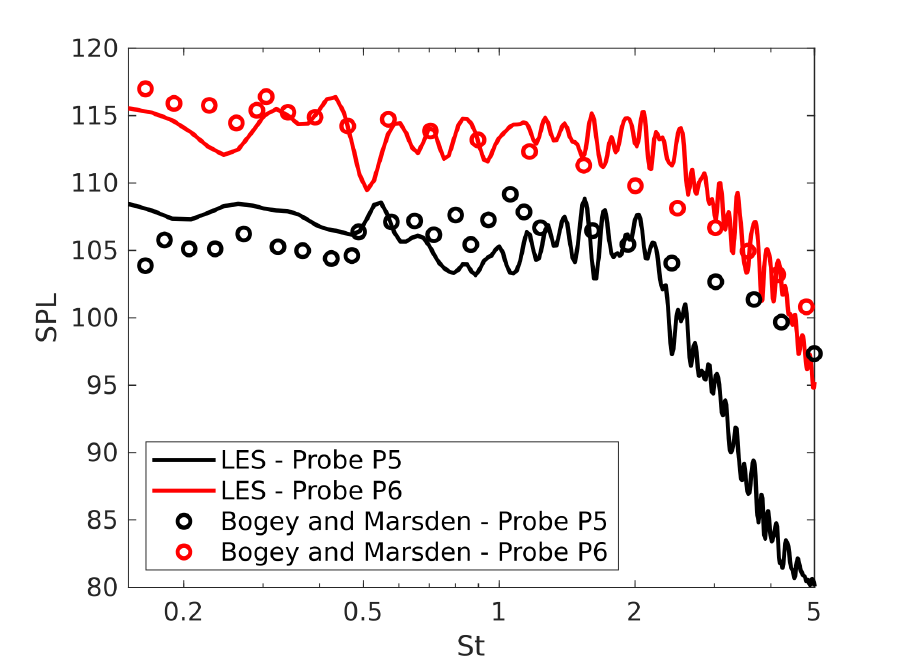
Figure 9. Comparing Near-Field LES Noise